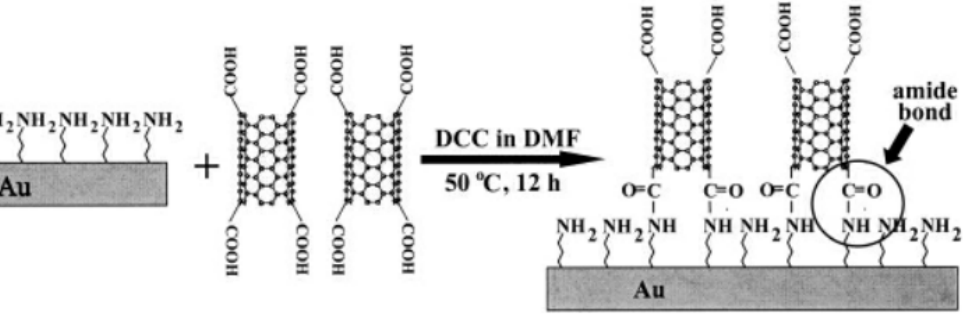
Figure 4. Schematic representation of the formation of SWNT assemblies. Reproduce with permission [53]. Copyright 2002, John Wiley and Sons.